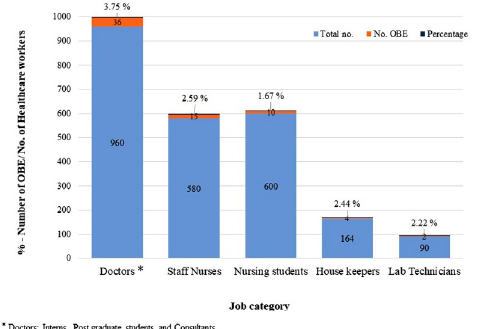
Fig. 2. Exposure rate among different catetgory of health care workers